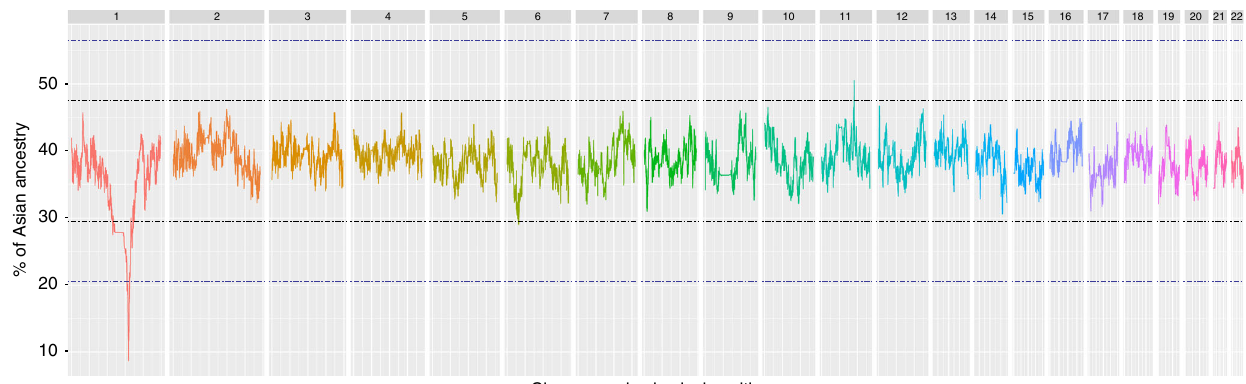
Fig. 1 Average Asian ancestry estimated using ELAI, across the 700 Malagasy individuals, for each position of each chromosome. In this analysis the African and Asian populations from the 1000 Genomes Project 22 were used as proxies for the African and Asian ancestry in the Malagasy; the results from other reference populations are provided in Supplementary Figure, and using other approaches and reference populations in Supplementary Figures 2 and 3. Black lines represent a deviation of 3 SD from the mean and blue lines represent a deviation of 6 SD from the